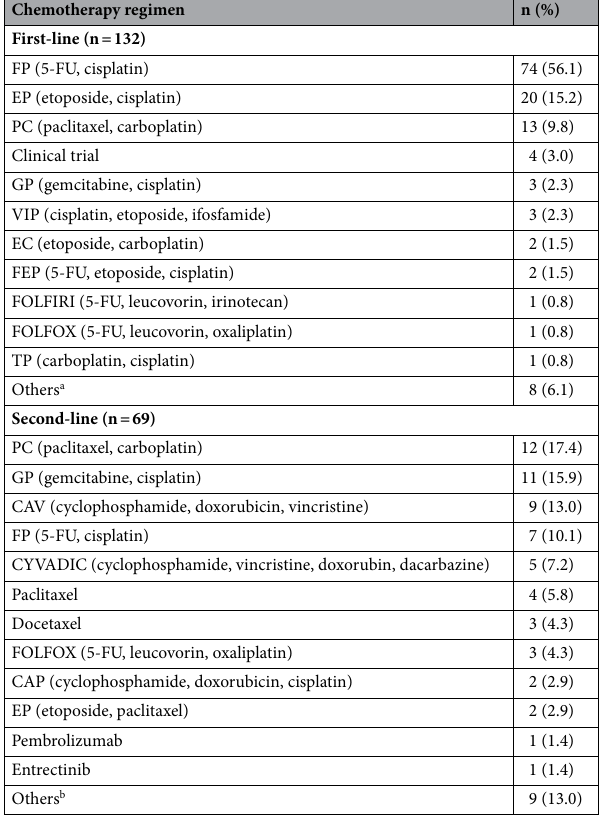
Table 4. First-line and second-line chemotherapy regimens used in patients with CUP. CUP carcinoma of unknown primary, FU fluorouracil. a Includes casodex/lucrin, CHOP (cyclophosphamide, doxorubicin, vincristine, prednisolone), DFP (docetaxel, 5-FU, CDDP), gemcitabine, octreotide, and CVD (cyclophosphamide, vincristine, dacarbazine) (n = 1 each). b Includes XELOX (oxaliplatin, capecitabine), afinitor, gemcitabine, irinotecan, IP, VIP (etoposide, ifosfamide, cisplatin), XP (capecitabine, cisplatin) + herceptin, ICE (ifosfamide, carboplatin. etoposide), and AP (doxorubicin, cisplatin) (n = 1